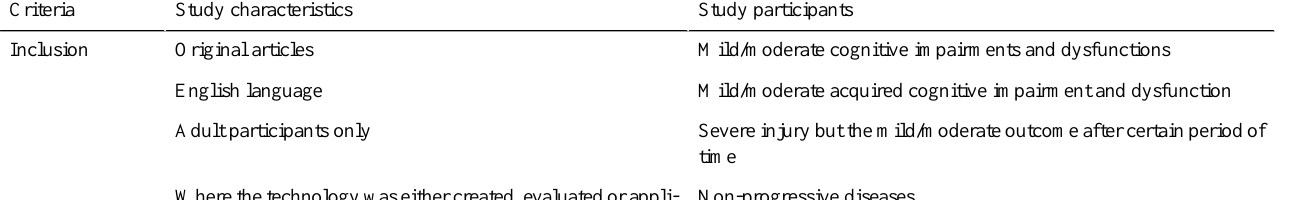
Table 1. Inclusion and exclusion criteria for literature review of information and communication technologies (ICT) used for minor acquired cognitive impairments